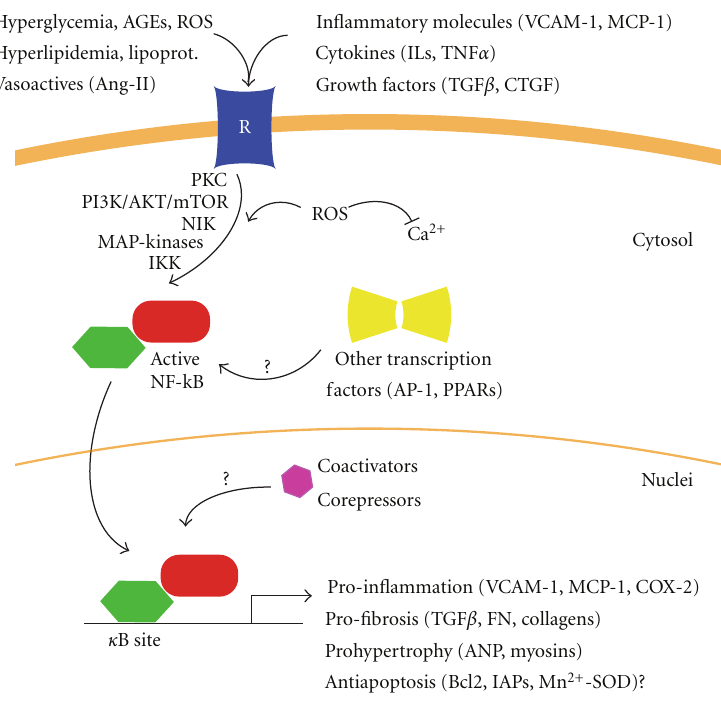
Figure 2: NF- κ B and DC-associated gen expression. Under diabetes mellitus, hyperglycemia, hyperlipidemia and other stimulated factors, such as cytokines or inflammatory molecules, activate the NF- κ B pathway in the heart. NF- κ B, depending on other transcription factors and coactivators/repressors interactions may regulate the expression of involved genes via di ff erent mediators. CTGF: connective tissue growth factor; ILs: interleukins; FN: